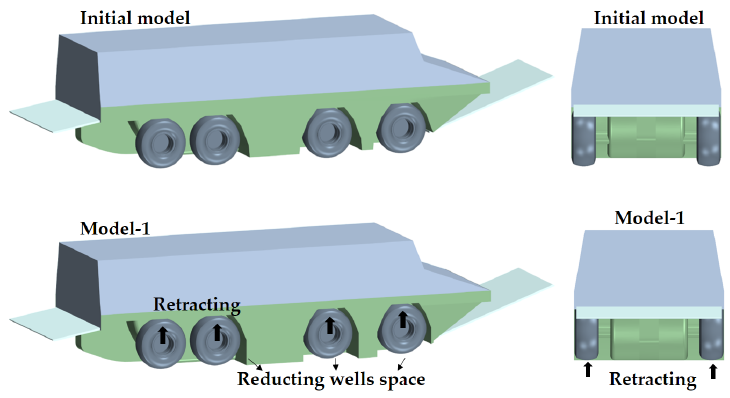
Figure 17. The geometry of the initial model and the Model-1.